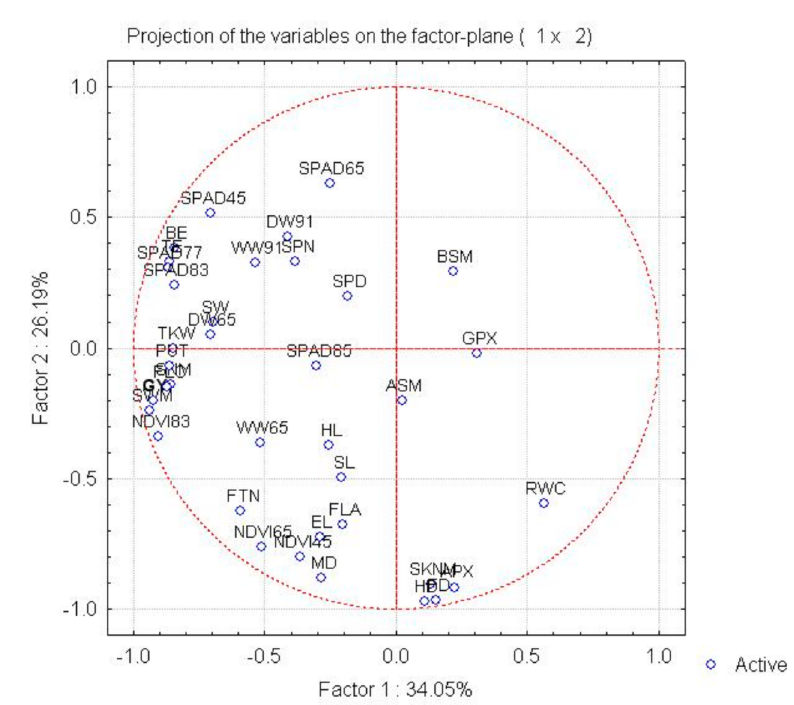
Figure 2. Correlation system demonstrated by principal component analysis between plant develop- ment, morphological, physiological and biochemical traits and the yield and yield components based on the parameter matrix formed from the mean values of rain-fed treatments over two years. The yield of the isogenic lines exhibited a significant correlation with the thousand- kernel weight (r = 0.735 *), the number of grains per main spike (r = 0.846 **), the grain weight (r = 0.844 **), the height parameters (FLC: r = 0.800 *; BE: r = 0.679 *; TE: r = 0.717 *), the vegetation activity of the plots at flowering and grain filling (r = 0.684 *, 0.863 **), the chlorophyll content of the flag leaf in phenophases Z77 and Z83 (r = 0.786 **, 0.772 **), the number of side-tillers per square meter (r = 0.689 *) and the dry biomass at flowering (r = 0.648 *). The APX enzyme activity was in significant positive correlation with the number of spikelets on the main spike (r = 0.803 ***), the guaiacol peroxidase